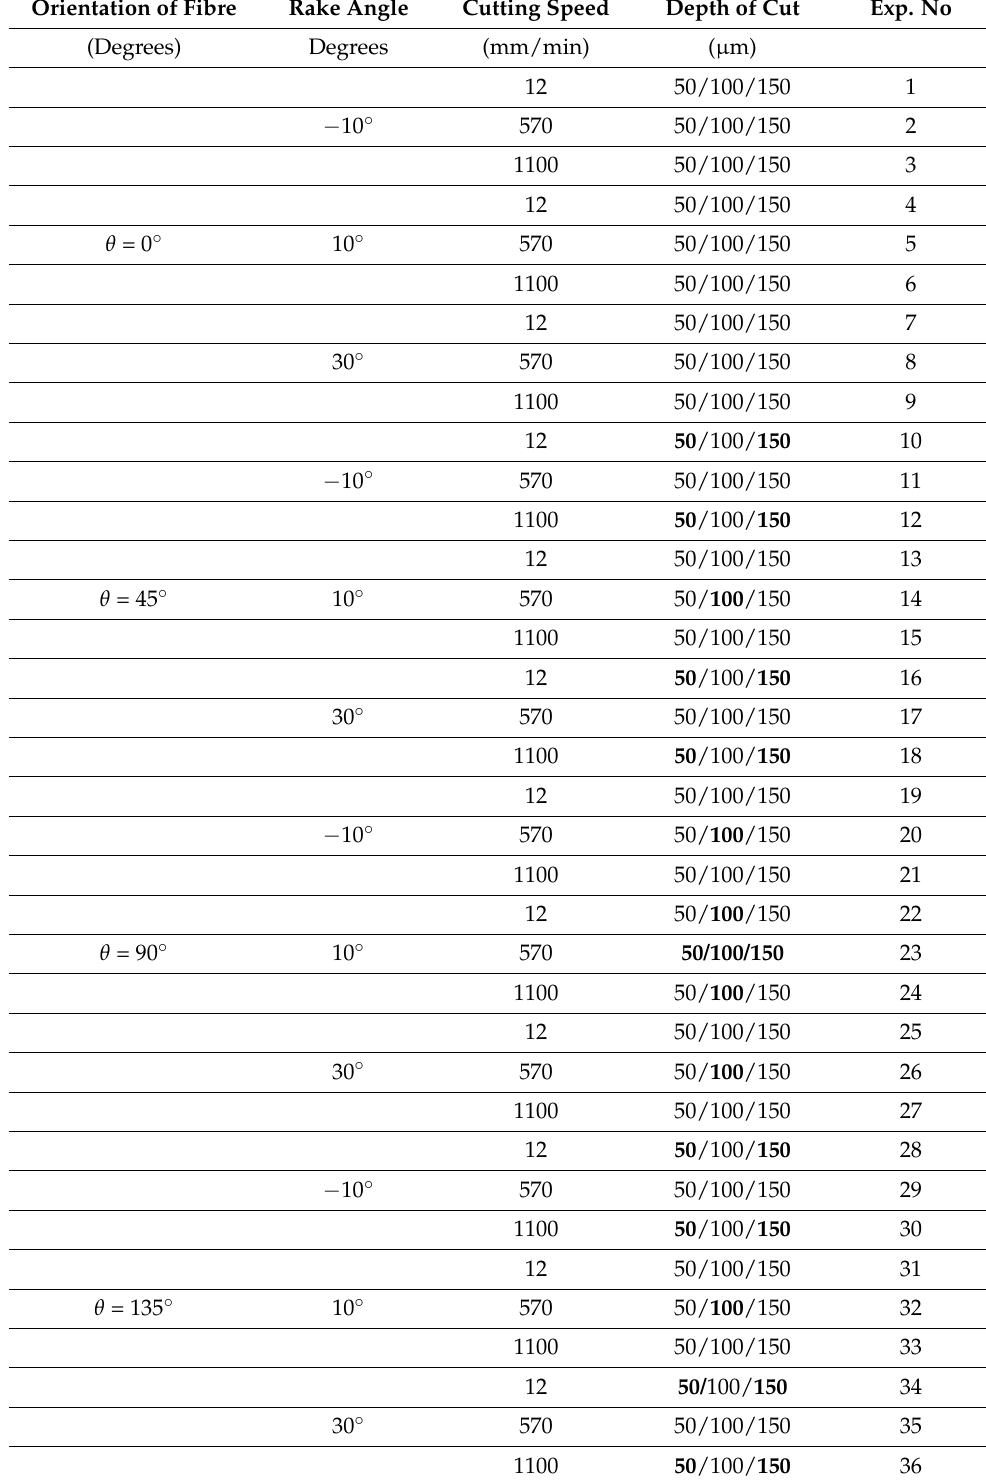
Table 3. The orthogonal cutting